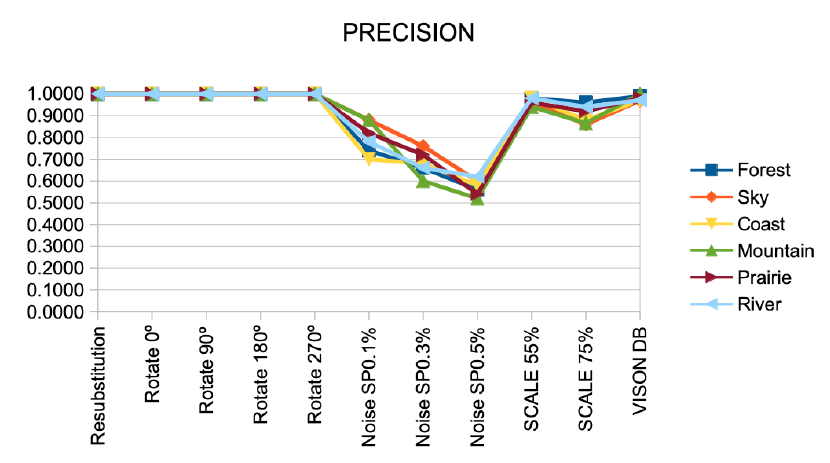
Figure 13. Shullani database [16] performance.